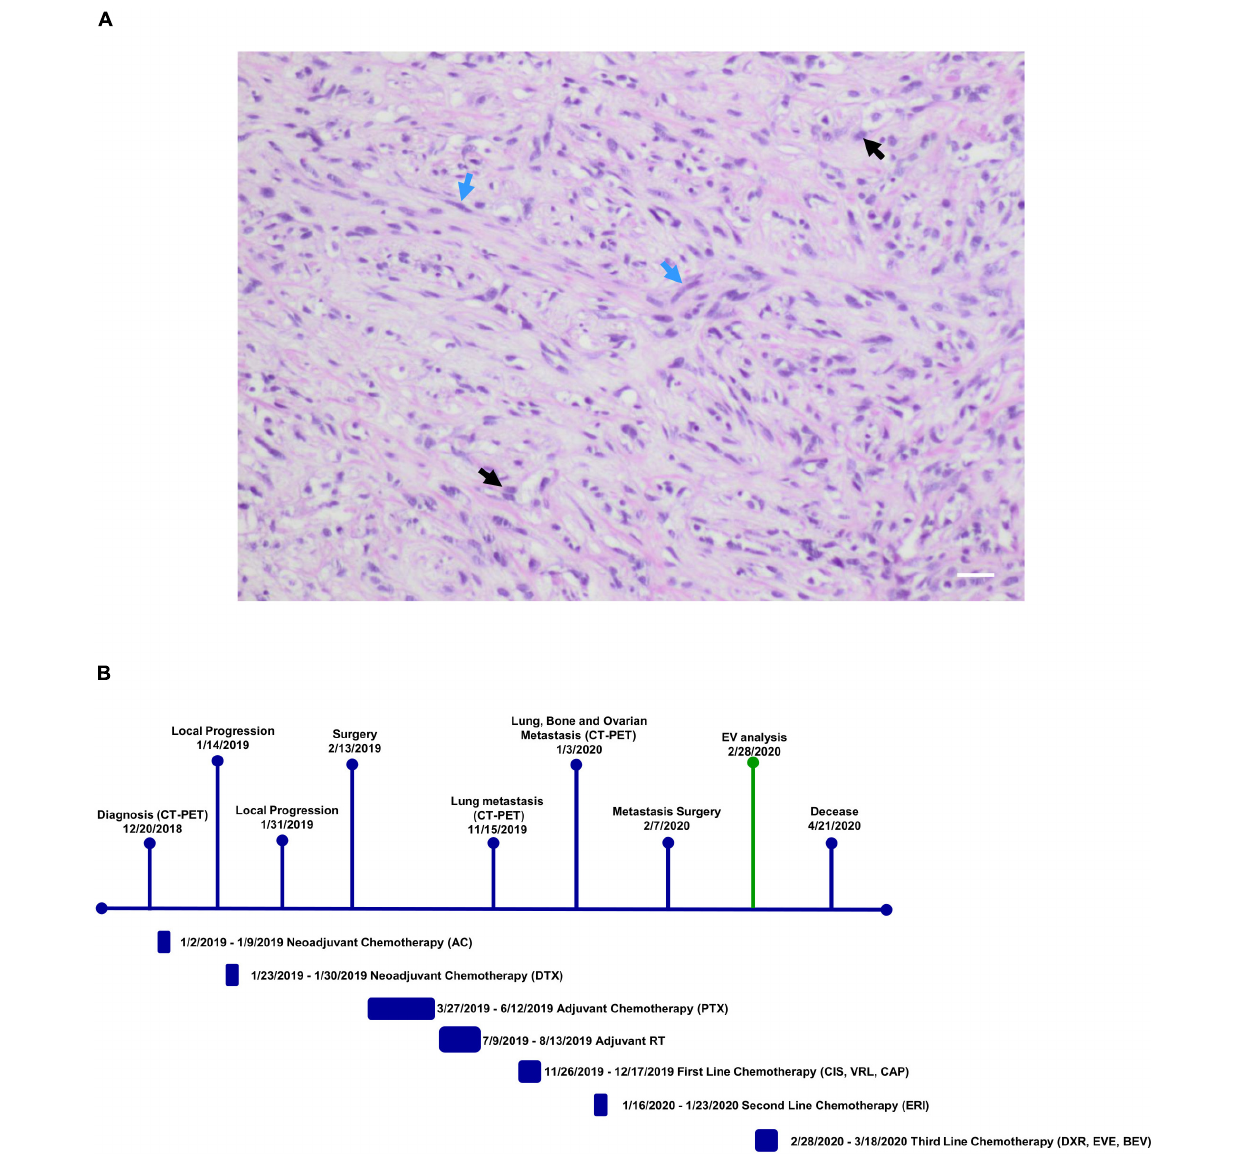
FIGURE 1 | (A) Microscopic eosin and hematoxylin image of metaplastic breast carcinoma (MpBC) with spindled (blue arrows) and oval (black arrows) cells. Scale bar = 50 µ m. (B) Patient timeline. Patient history showing her clinical course above and therapy administered to patient below. CT-PET, computed tomography-positron emission tomography; AC, adryamicin-cyclophosphamide; DTX, docetaxel; PTX, paclitaxel; CIS, VRL, CAP, cisplatin, vinorelbine, capecitabine; ERI, eribulin; DXR, EVE, BEV, doxorubicin, everolimus, bevacizumab; EV analysis, extracellular vesicle analysis.